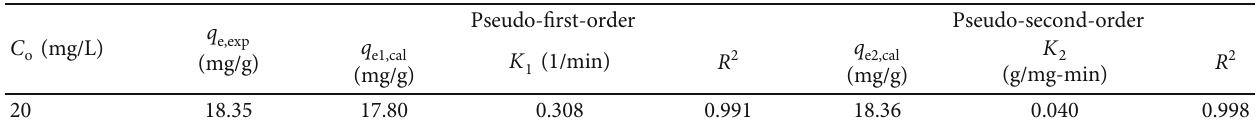
Table 3: Kinetic model parameters for MG adsorption on Fe